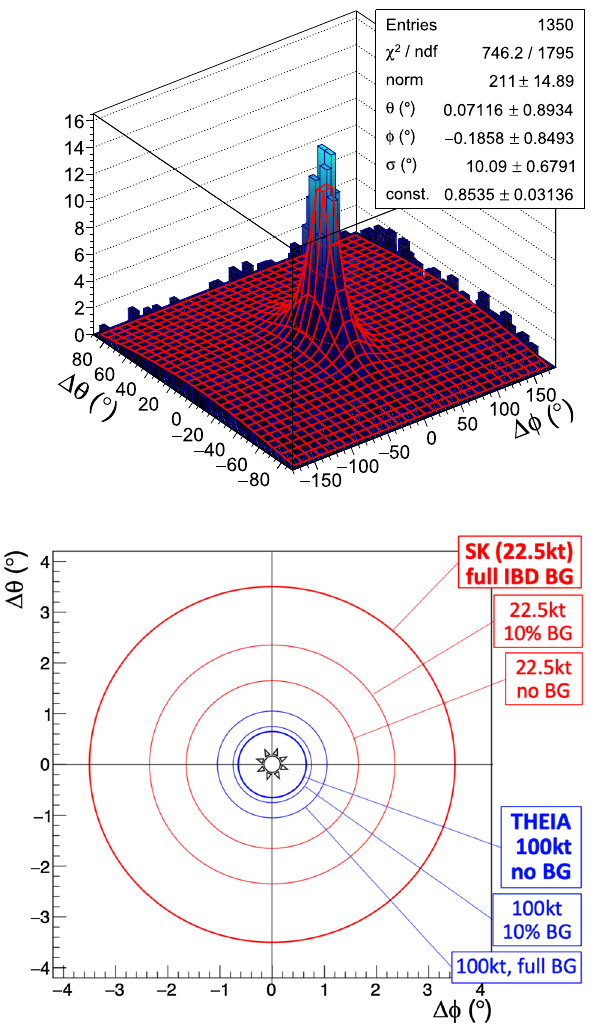
Fig. 12 SN pointing capability of Theia , based on the reconstruction of the ES directional signal. Top panel: example angular distribution, assuming90%intheflatIBDspectrum.Basedonafittothisandsimilar distributions (red net), the bottom panel depicts the pointing accuracy for Theia , assuming different IBD background levels for 100kt as well as 22.5kt target mass (comparable to